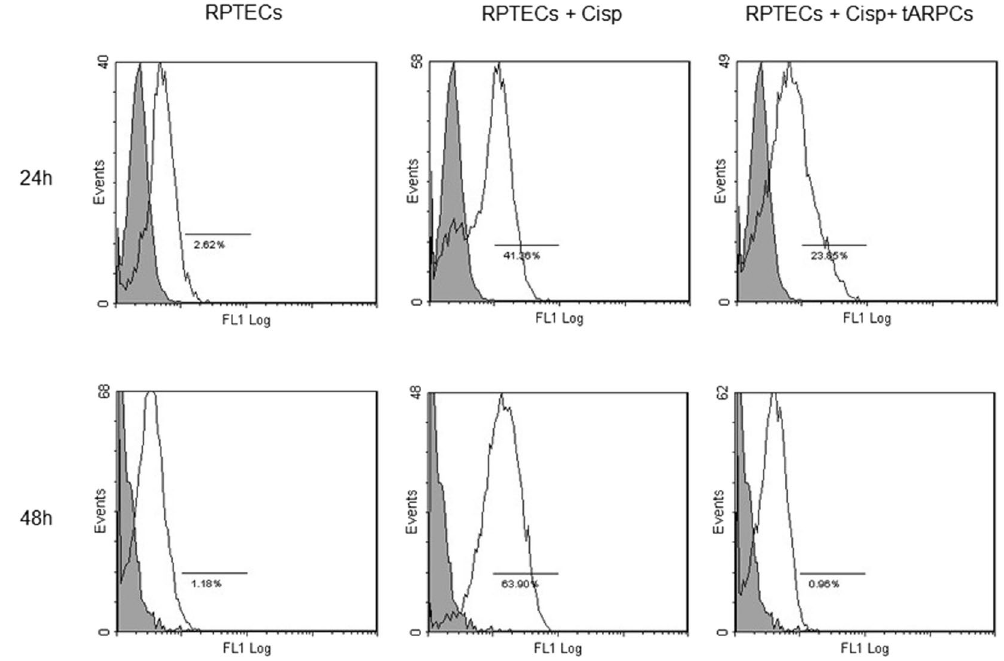
Figure 3. tARPCs can abrogate cisplatin-induced apoptosis of RPTECs. After cisplatin administration, the number of cleaved-caspase 3 positive RPTECs significantly increased to 41% after 24 hours and to and 63.9% after 48 hours. Conversely, when RPTECs were co-cultured with tARPCs, apoptotic cells decreased to 24% after 24 hours, whereas after 48 hours, apoptosis was completely blocked and RPTECs did no longer express cleaved- caspase 3. Results are representative of three independent experiments.